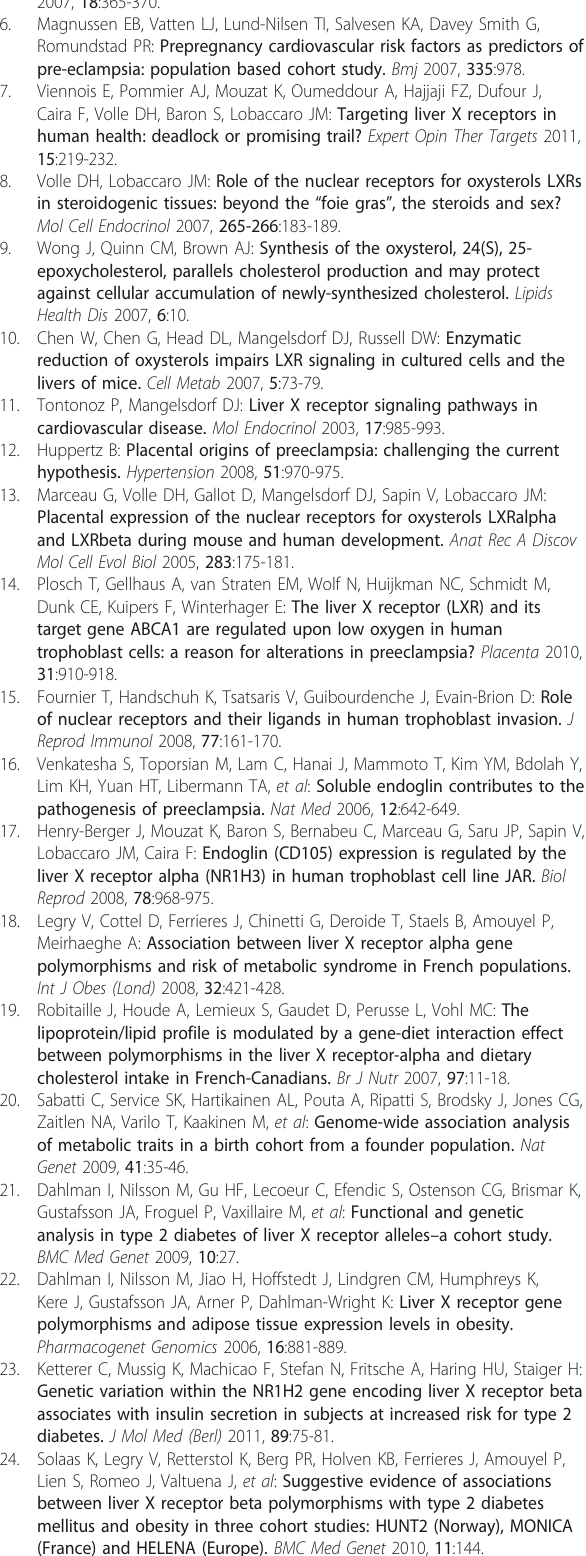
Additional file 1: Figure S1: Linkage disequilibrium between NR1H3 and NR1H2 SNPs . The r 2 values are shown. D ’ was 0.97 and 0.85 between SNPs within the NR1H3 (LXRalpha) and NR1H2 (LXRbeta) genes, respectively.